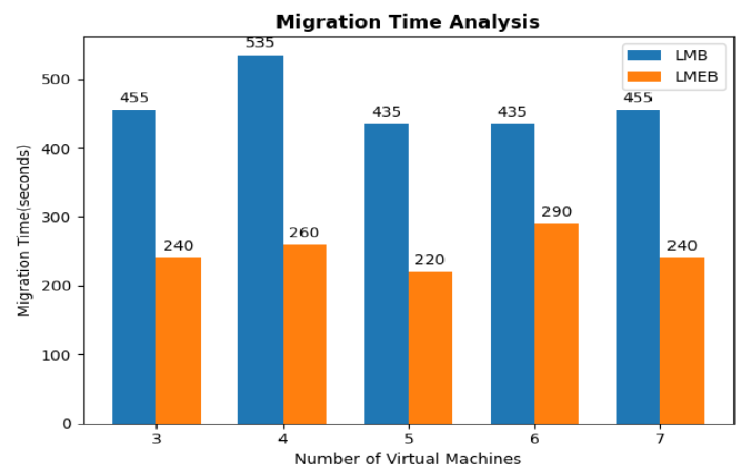
Figure 7. Migration time analysis.